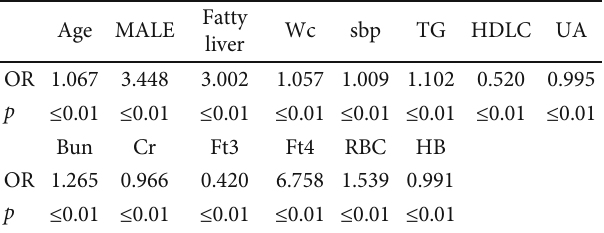
Table 4: Logistic regression analysis of risk factors for elevated